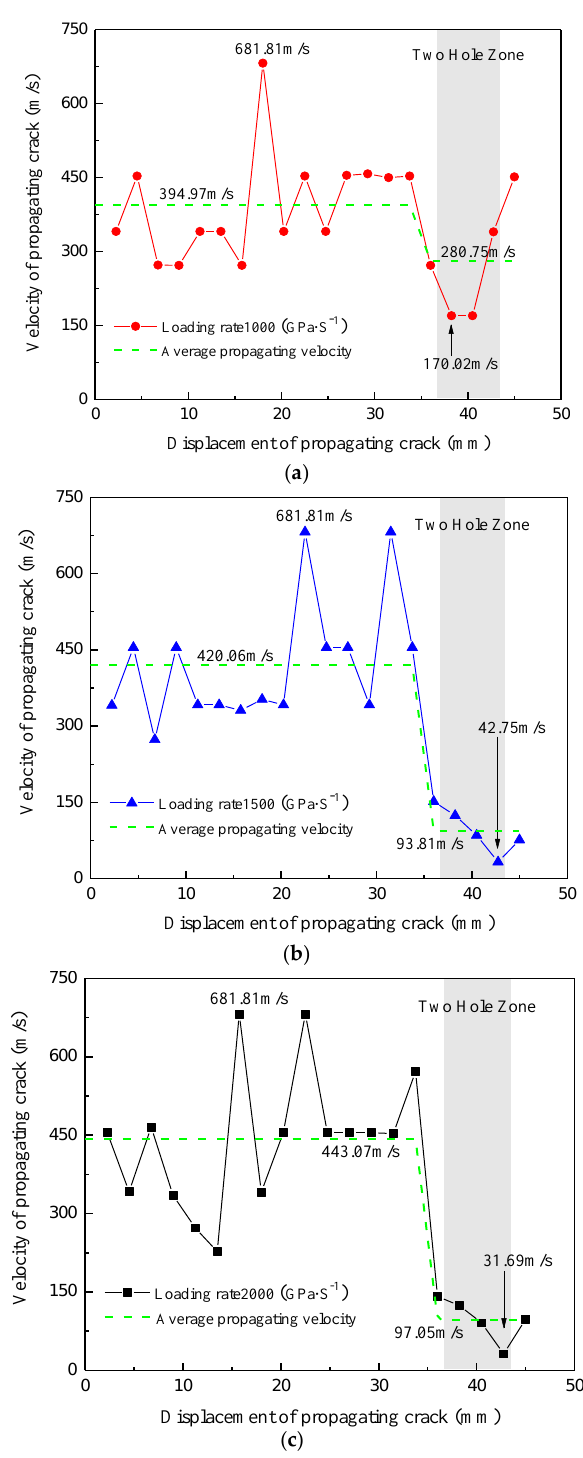
Figure 9. Contrast diagram of crack propagation velocity under di ff erent loading rates ( a ) The crack propagating velocity curves of HT-1 specimen under loading rate 1000 GPa · s − 1 . ( b ) The crack propagating velocity curves of HT-2 specimen under loading rate 1500 GPa · s − 1 . ( c ) The crack propagating velocity curves of HT-3 specimen under loading rate 2000 GPa · s − 1